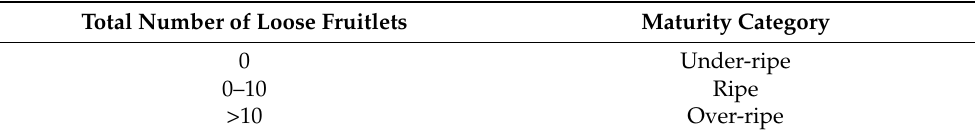
Table 1. Oil palm FFB maturity categories are based on the total number of empty sockets representing the total number of loose fruitlets